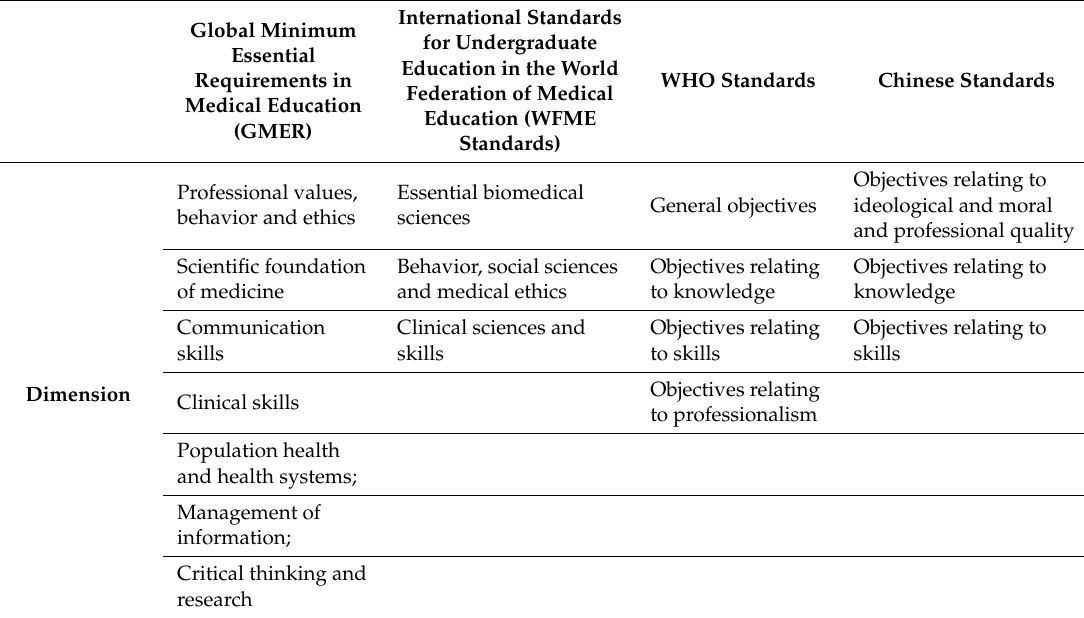
Table 1. Dimensions of four medical education